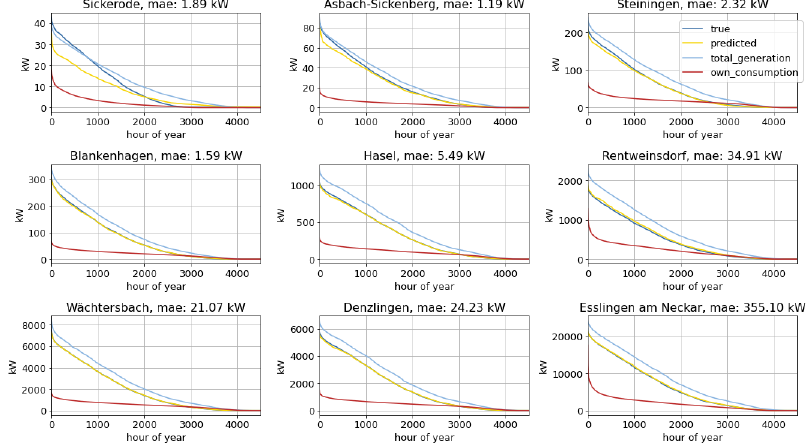
Figure 13. Supply duration curves for nine municipalities of different sizes, including the ground